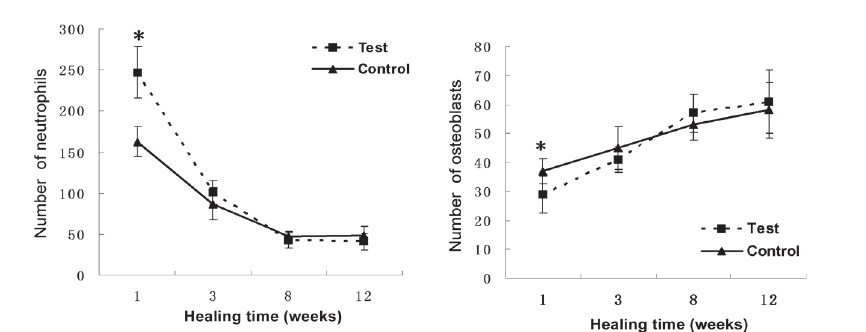
Figure 4- Graphs showing the changes in the density of neutrophil and osteoblast in both groups at 1, 3, 8 and 12-weeks healing time. * indicates statistically significant differences